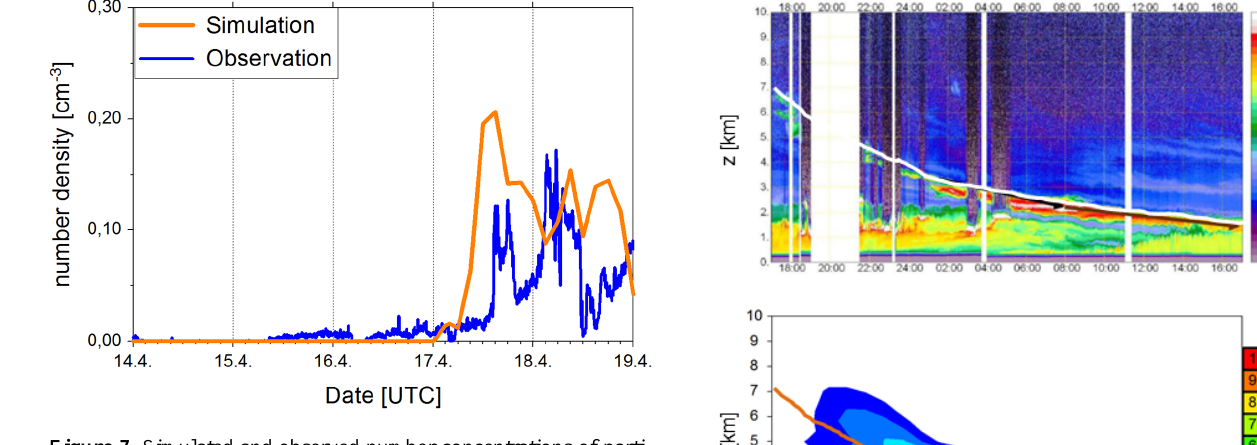
Figure 7. Simulated and observed number concentrations of parti- cles with a diameter of 3µm at Hohenpeissenberg, Germany.